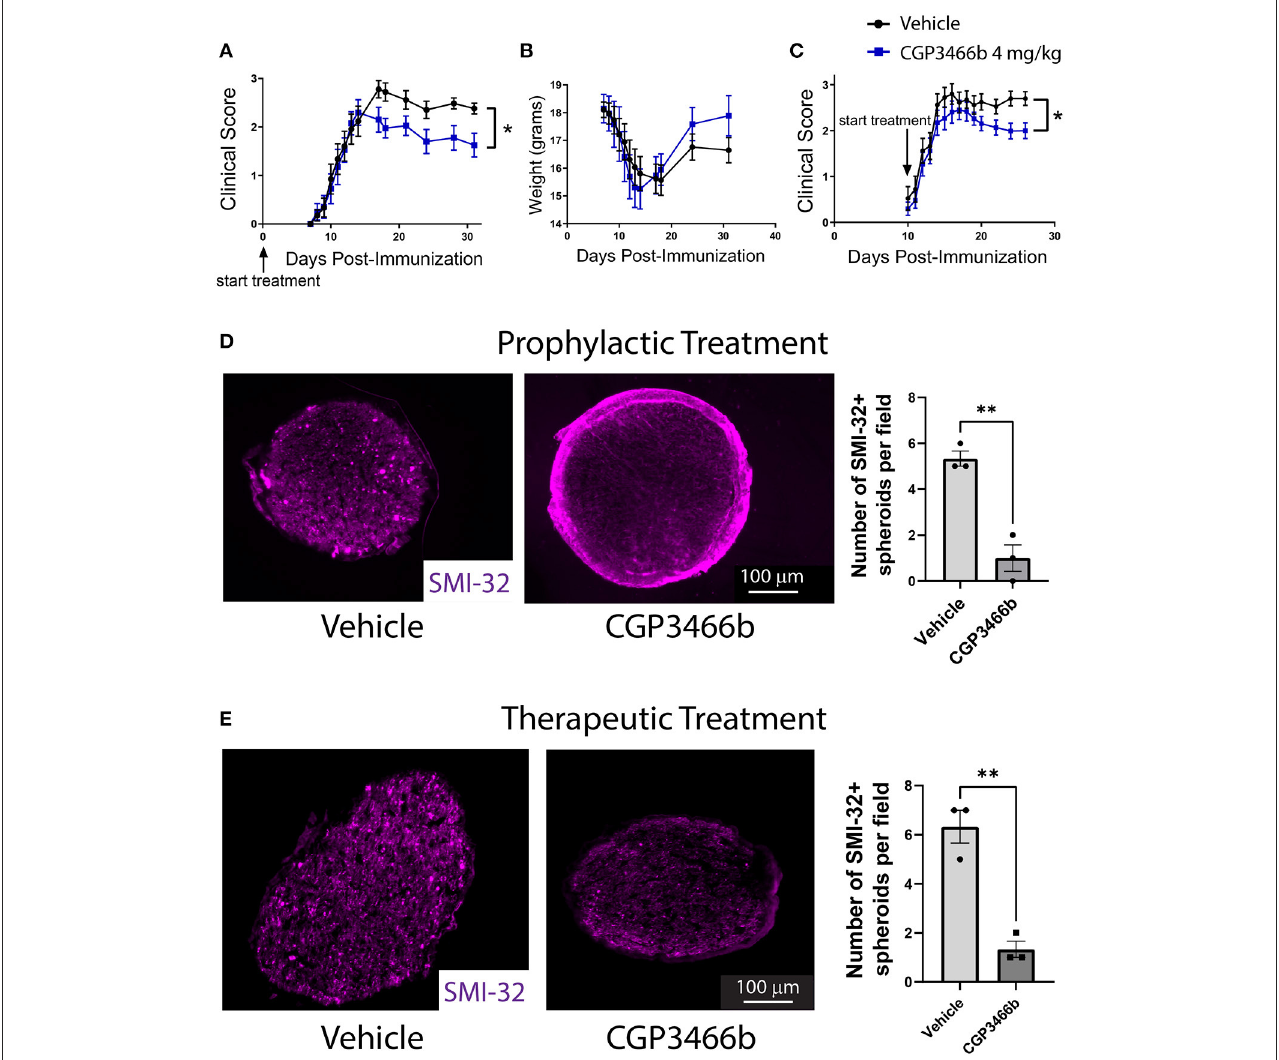
FIGURE2 Blocking SNO-GAPDH with CGP3466b is neuroprotective in MOG 35 − 55 EAE. (A, B) CGP3466b 4 mg/kg was administered by daily i.p. injection beginning on post-immunization day 0 (prophylactic paradigm). Clinical scoring was performed by a blinded observer. Prophylactic treatment with CGP3466b attenuated neurologic deficits (A) without impacting weight loss (B) . Data represent n = 17 (vehicle) and n = 10 (CGP3466b) mice per group. (C) CGP3466b 4 mg/kg was administered by daily i.p. injection beginning on post-immunization day 10 (therapeutic paradigm), and clinical scoring was performed by a blinded observer. Data represent n = 20 (vehicle) and n = 26 (CGP3466b) mice per group. (D) To quantify axonal injury, mice were treated with vehicle or CGP3466b 4 mg/kg by daily i.p. injection beginning on post-immunization day 0, and SMI-32 + axonal spheroids were examined via immunofluorescence staining of proximal optic nerve at post-immunization day 28. A representative image is shown (left), along with quantification performed from n = 3 mice per group (right). (E) Mice were treated with vehicle or CGP3466b 4 mg/kg by daily i.p. injection beginning on post-immunization day 10, and SMI-32 + axonal spheroids were examined via immunofluorescence staining of proximal optic nerve at post-immunization day 28. A representative image is shown ( left ), along with quantification performed from n = 3 mice per group ( right ). * p < 0.05, ** p < 0.01 by Mann-Whitney U-test (A, C) or student’s t -test (D, E) . Data shown as mean ±